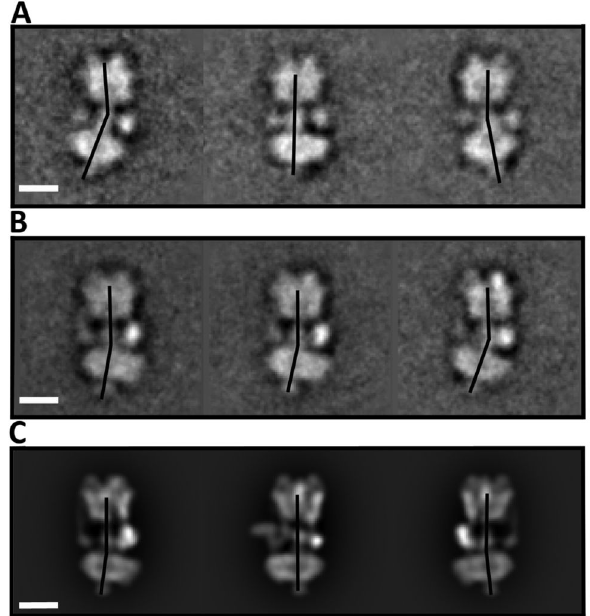
Figure 3. Cryo-EM analysis of Flexibility in Manduca V- ATPase. (A, B) Single particle cryo-EM analysis of the M . sexta V-ATPase enzyme aligned against V against V . (C) Reprojections from the M . sexta reconstruction o showing the greatest displacement of V bars represent